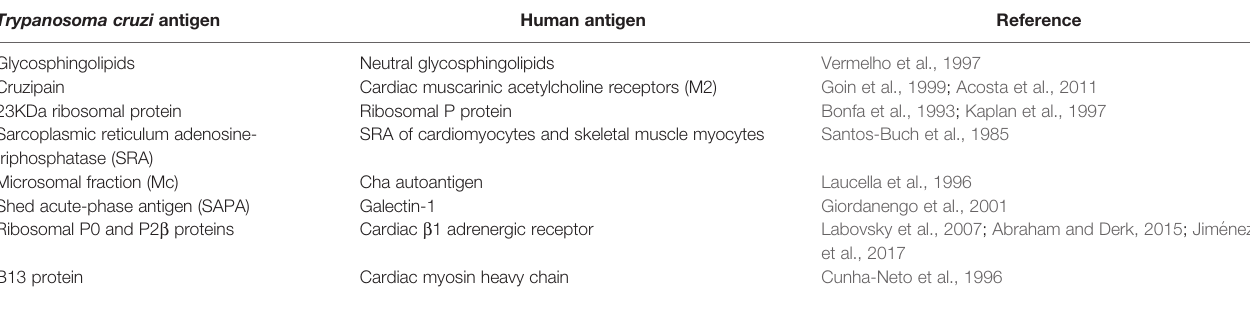
TABLE 1 | Cross-reactivity between T. cruzi and human antigens with possible implications in Chagasic cardiomyopathy. Trypanosoma cruzi